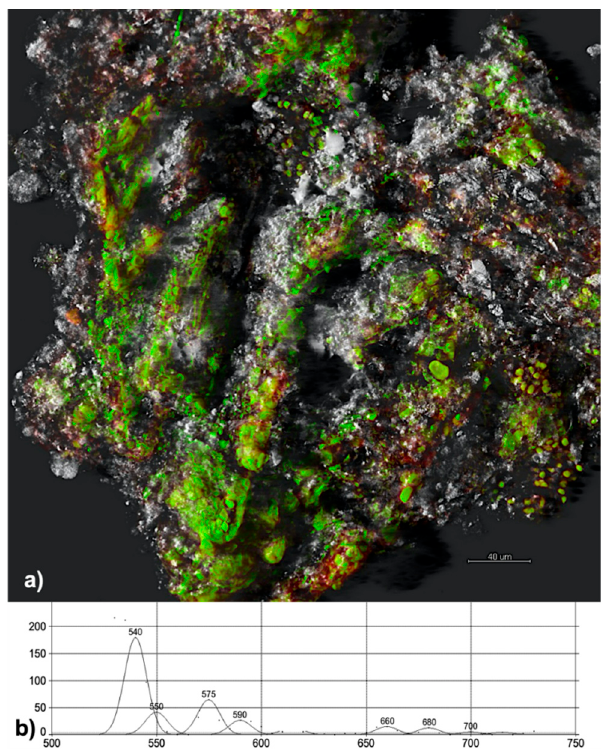
Figure 5. ( a ) Confocal laser scanning imaging of biofilm growing on treated Candoglia marble. Colour key: phototrophs, red (autofluorescence); chemotrophs, green (Syto9); stone, grey (reflection). Scale bars are 40 µm. ( b ) Emission spectrum recorded from coccoid cyanobacterial cells. The spectral profile shows characteristic emission peaks between 540 and 590 nm corresponding to thylakoid disorganization.